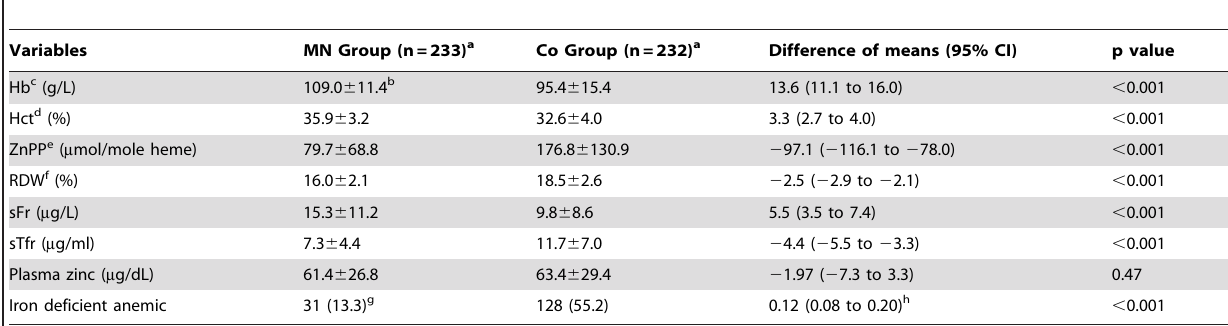
Table 5. Effect of micronutrient fortified milk on hematological parameters and plasma zinc status among fortified milk vs. control milk group children after 1 year of